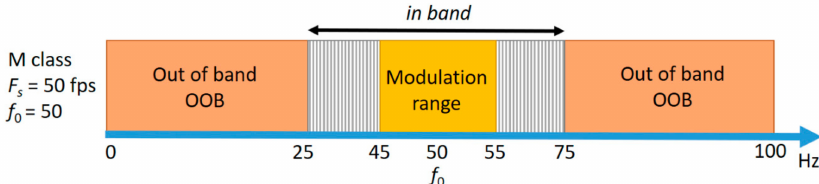
Figure 2. Out-of-band region, in band range, and modulation range for M Class with reporting rate 50